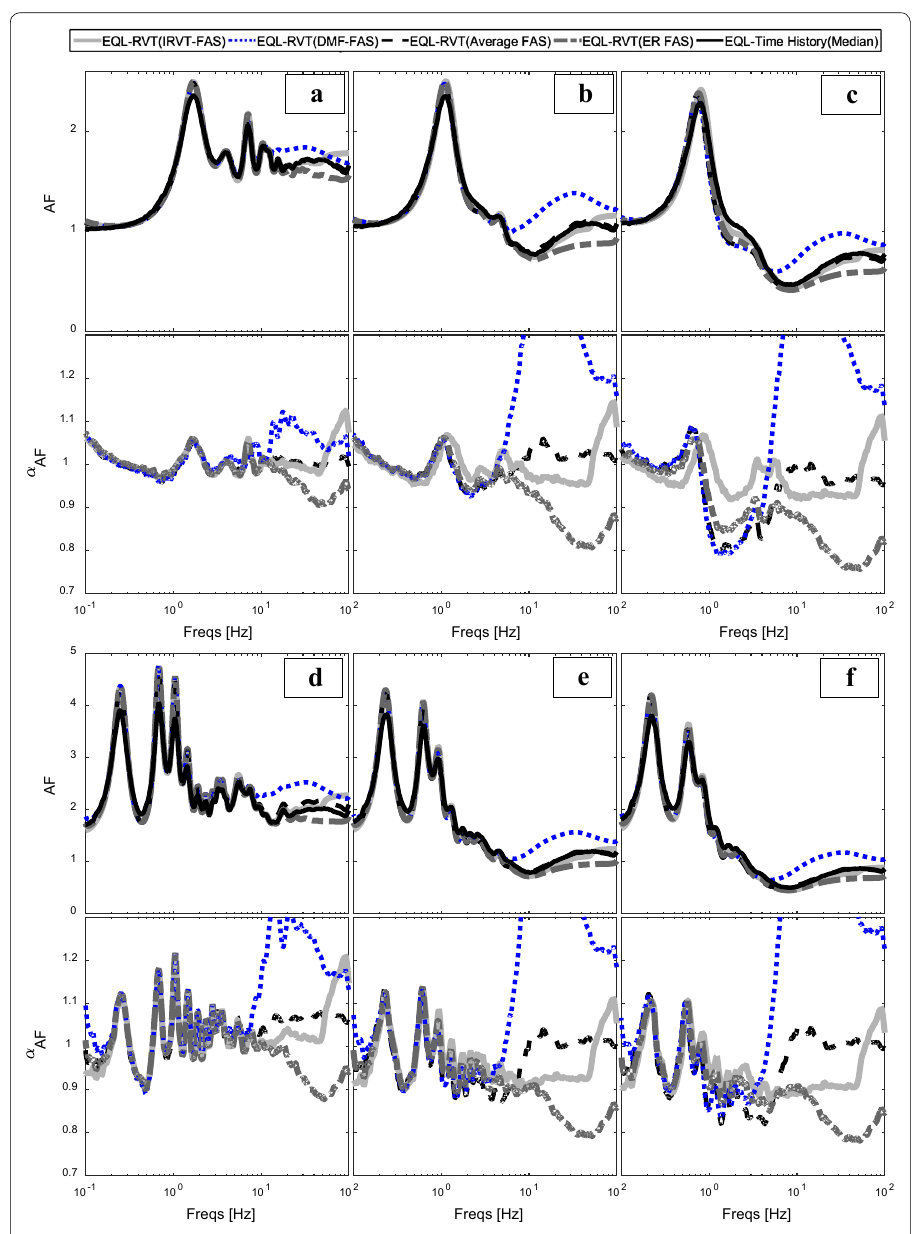
Fig. 8 AFs and α AF s obtained using inputs compatible with the NGA spectrum. Top figures show the results for the SCH site at PGAs average values of 0.01 g ( a ), 0.3 g ( b ) and 0.6 g ( c ). Bottom figures show the results for the and CC site at 0.01 g ( d ), 0.3 g ( e ) and 0.6 g ( f